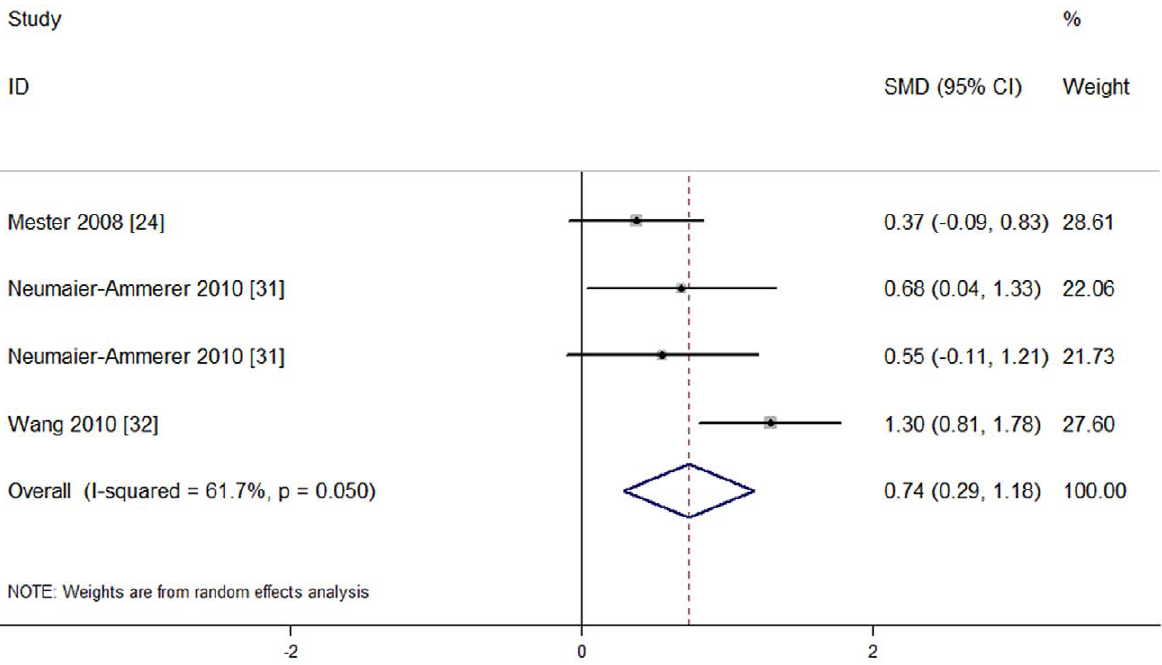
Figure 8. Meta-analysis of postoperative color vision in the blue light spectrum under mesopic light condition.